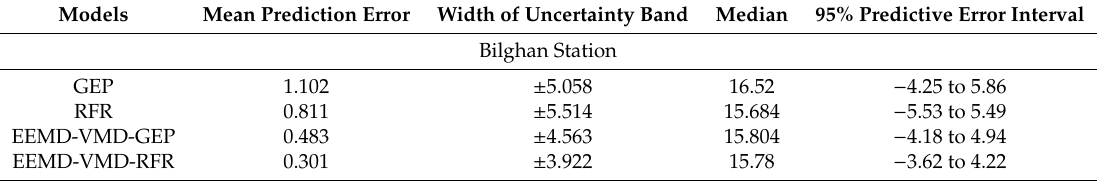
Table 8. Uncertainty analyses for streamflow prediction using predictive models at Bilghan station.